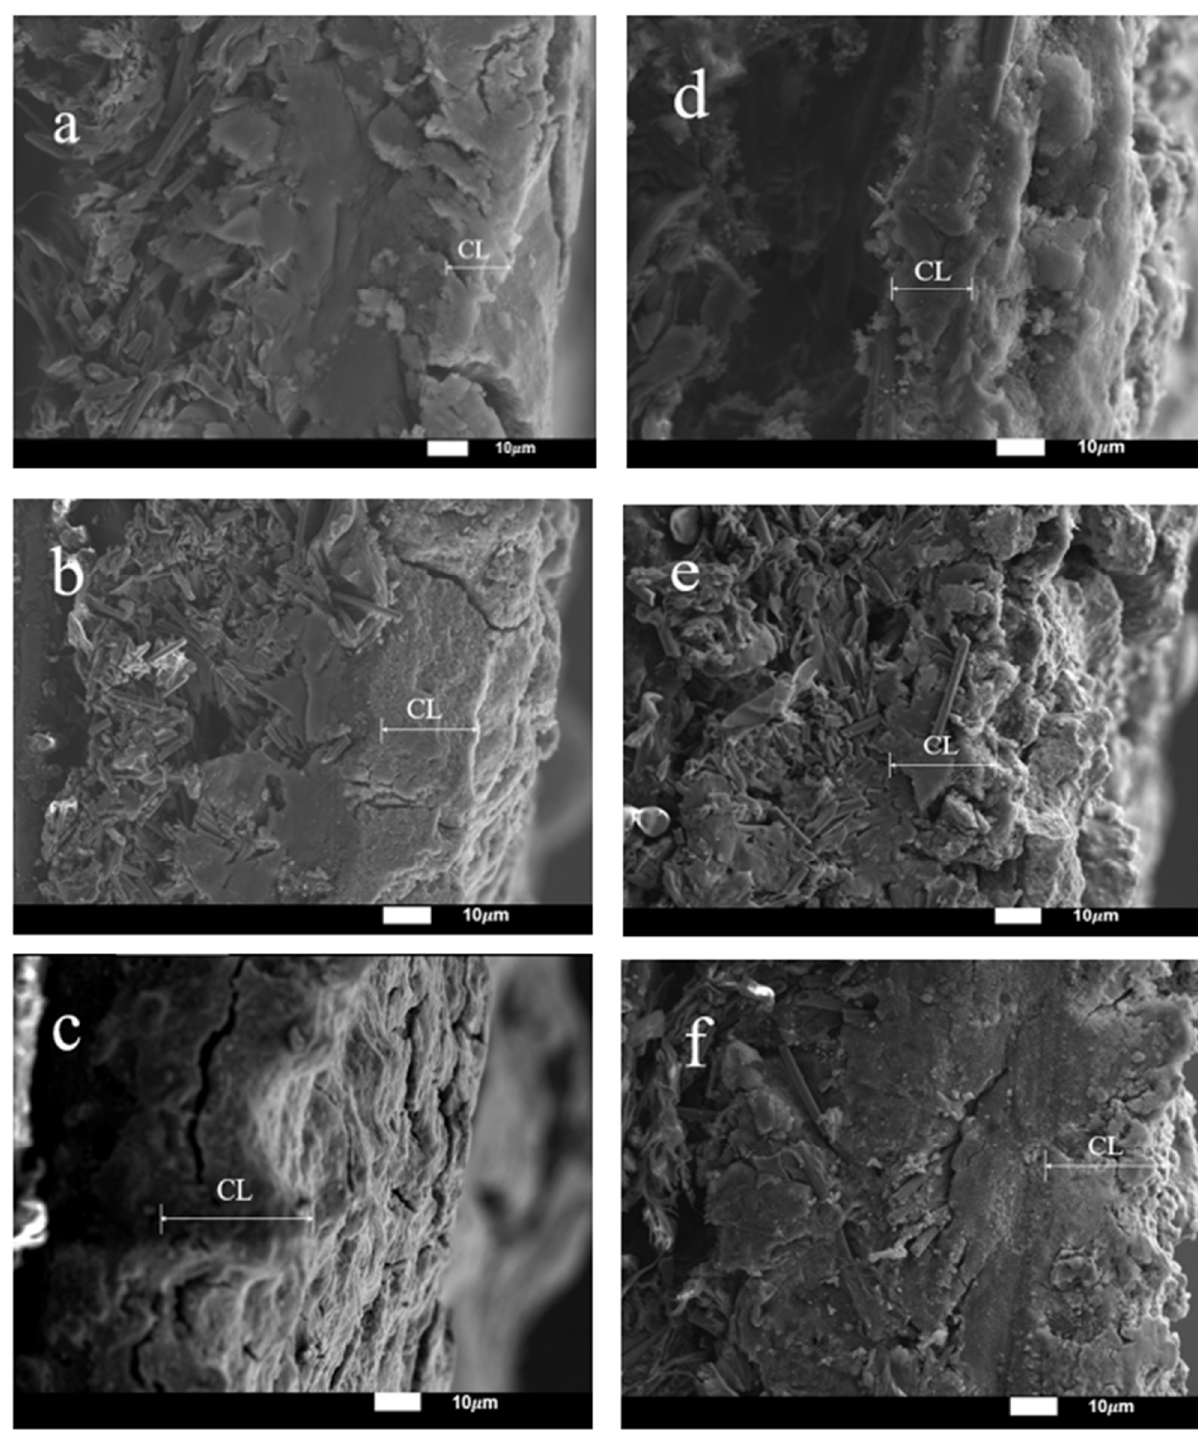
Figure 2. Cross-sectional SEM images of MEAs with different platinum loadings: ( a ) cathode 1.0 mg cm − 2 , ( b ) cathode 2.0 mg cm − 2 , ( c ) cathode 3.0 mg cm − 2 , ( d ) anode 1.0 mg cm − 2 , ( e ) anode 2.0 mg cm − 2 , ( f ) anode 3.0 mg cm − 2 .